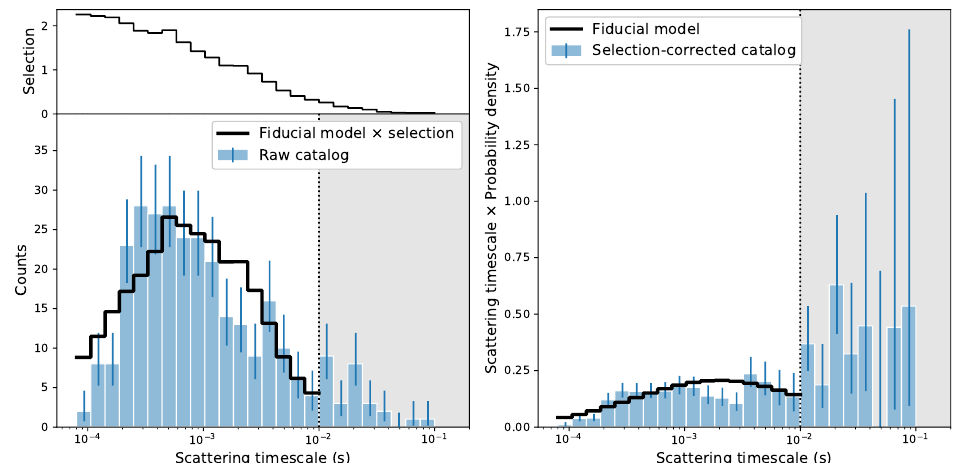
Figure 7. Figure 17 from [14] “The First CHIME/FRB Fast Radio Burst Catalog”, reproduced with permission from Kiyoshi Masui, submitted to ApJS. It shows scattering times before and after correction for systematics adopted following the results of the injection process developed to control biases of the survey. It is evident that a large fraction of highly scattered events might be missed by CHIME for scattering > 10